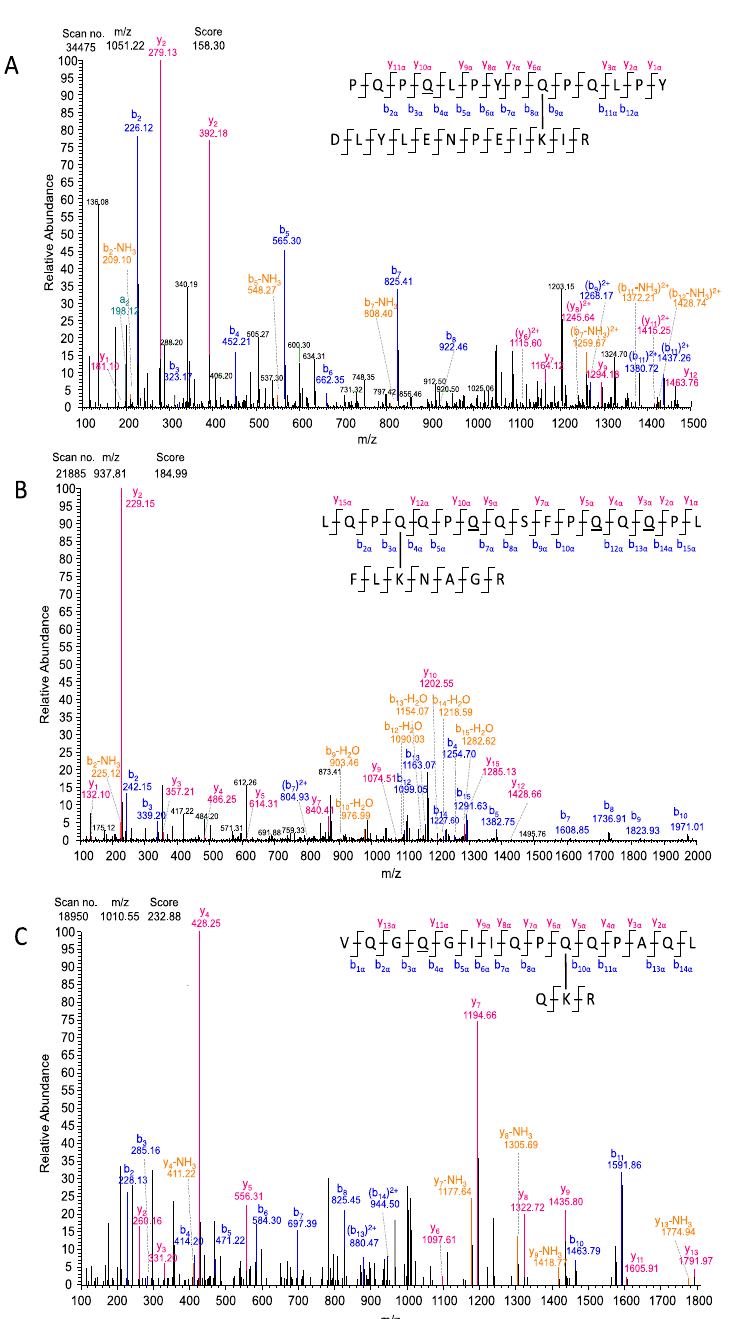
Figure 5. MS / MS spectra of the isopeptides between the three model peptides of the advanced model system and TG2. ( A ) Spectrum of the isopeptide between peptide P1 PQPQLPYPQPQLPY crosslinked to TG2 peptide DLYLENPEIKIR and annotated with fragments of P1 by MaxQuant Viewer. ( B ) Spectrum of the isopeptide between peptide P2 LQPQQPQQSFPQQQPL and TG2 peptide FLKNAGR annotated with fragments of P2 by MaxQuant Viewer. ( C ) Spectrum of the isopeptide between peptide P3 VQGQGIIQPQQPAQL crosslinked to TG2 peptide QKR annotated with fragments of P3 by MaxQuant Viewer. The fragments are marked in different colors as follows: y-fragments in red; b-fragments in blue; fragments with losses of NH 3 or CO marked in orange. The deamidated glutamine residues are underlined.